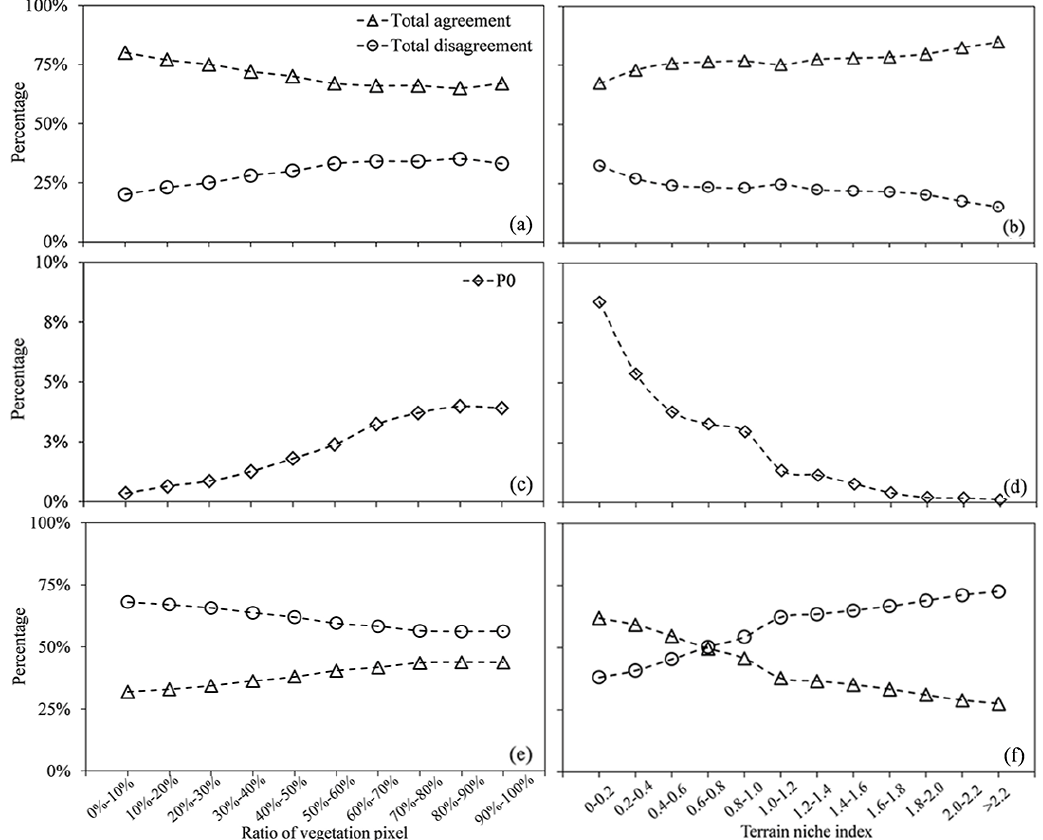
Figure 10. The statistical distribution of agreed positive trends (P0) calculated by LAI, FVC, and GPP varying with the ratio of vegetation pixel ( a ) and terrain niche index ( b ). The statistical distribution of comprehensive assessment results of the tendency ( c , d ) and correlation ( e , f ) of three products varying with the ratio of vegetation pixel and terrain niche index are shown.